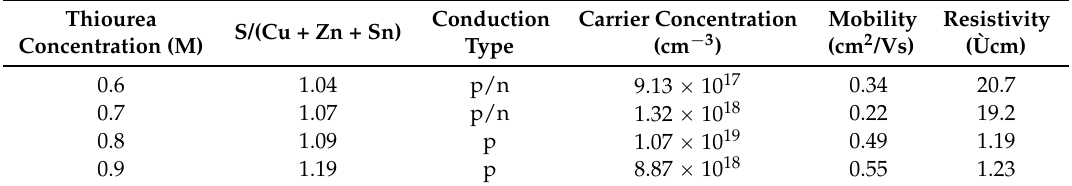
Table 1. The S/(Cu + Zn + Sn) atomic content ratio and electrical characteristics of copper-zinc-tin-sulfur (CZTS) thin films with different thiourea concentration.